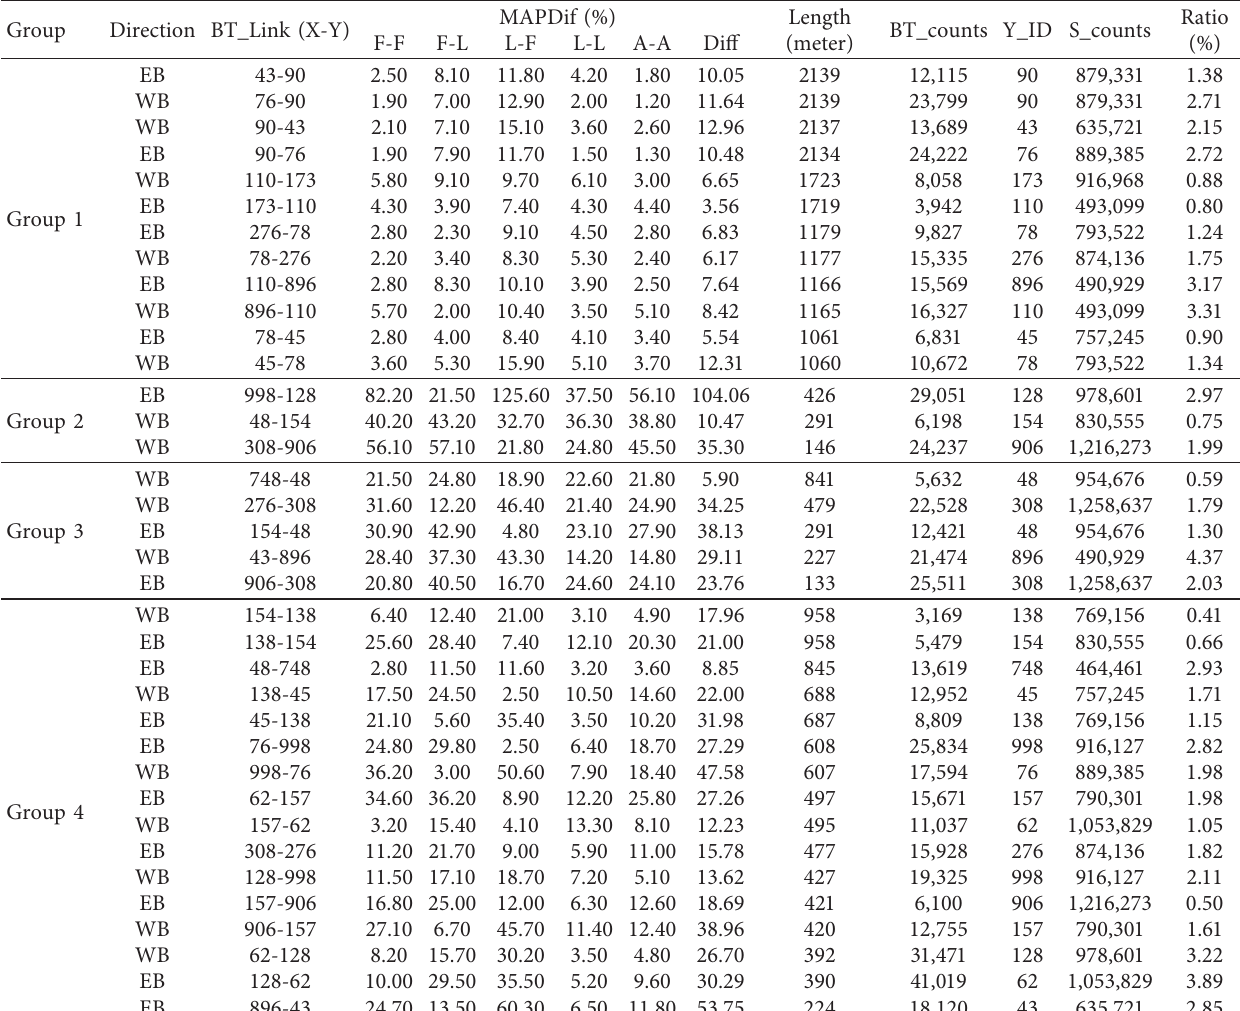
Table 3: The MAPDiff of all BT links of Canning